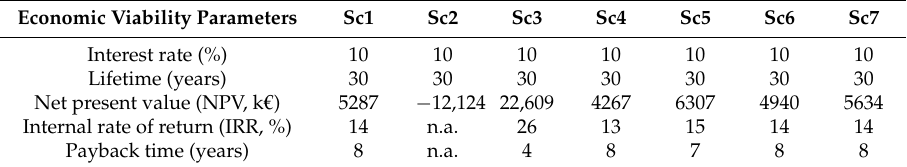
Table 9. Economic viability of the proposed project in each of the studied scenarios.